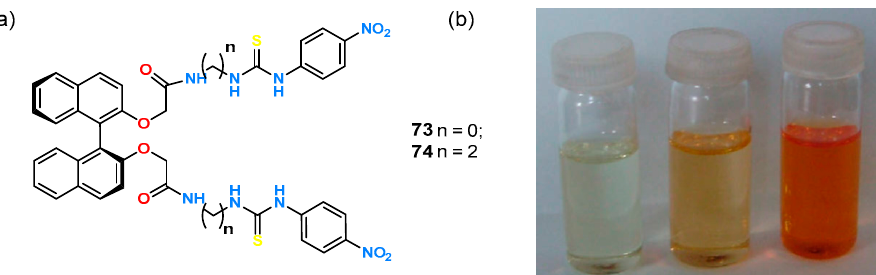
Figure 25. ( a ) BINOL receptors 73 and 74 ; ( b ) effect of the anion addition on color changes of receptor 74 in DMSO. From left to right, 74 ( 5.0 × 10 (cid:2879)(cid:2873) mol L(cid:3415) ), 74 ( 5.0 × 10 (cid:2879)(cid:2873) mol L(cid:3415) ) + 30 eq of R -mandelate, 74 ( 5.0 × 10 (cid:2879)(cid:2873) mol L(cid:3415) ) + 30 eq of S -mandelate.